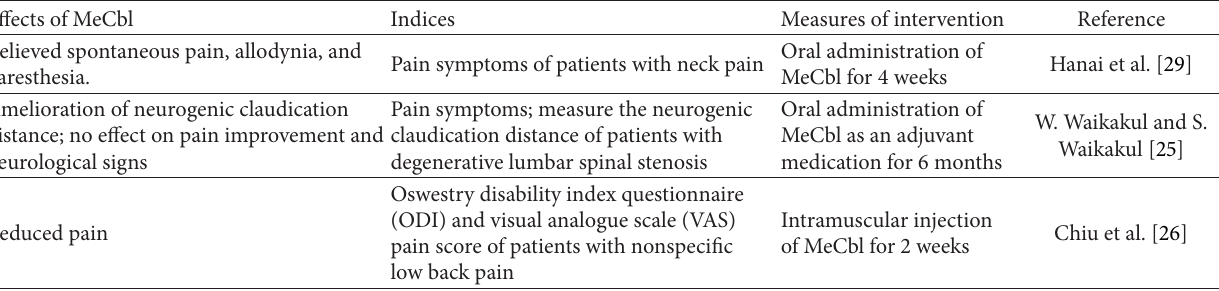
Table 2: The analgesic effects of MeCbl on low back pain and neck pain in clinical trials. Effects of MeCbl